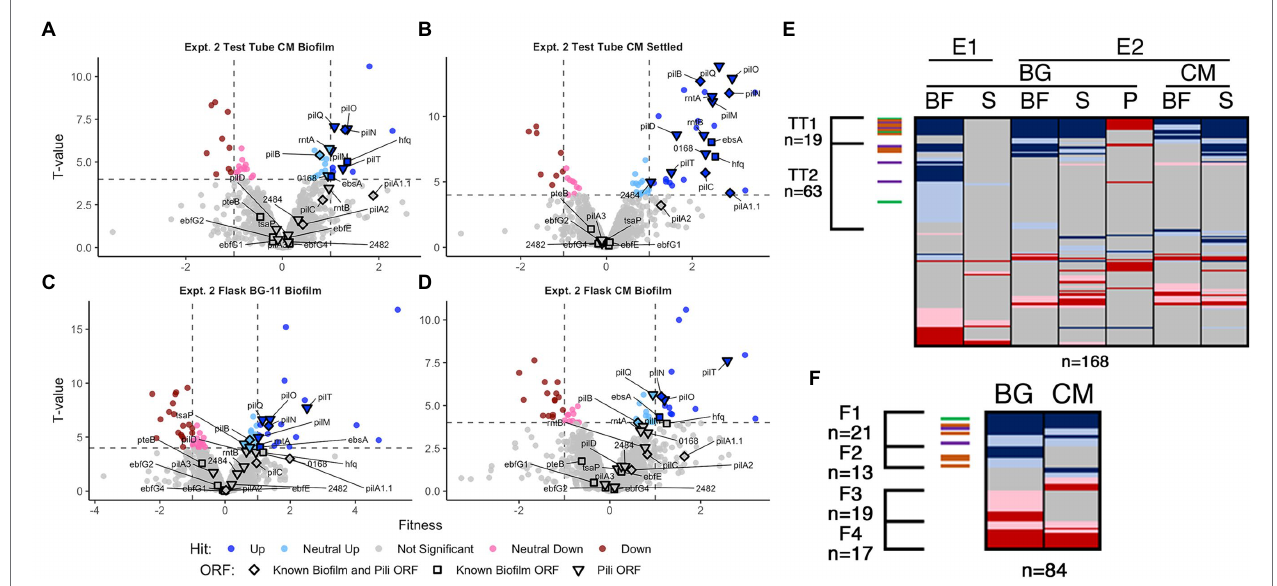
FIGURE 4 | Conditioned media and flask RB-TnSeq analysis Volcano plots of CM test tube (A) biofilm and (B) settled fractions, and biofilm fractions from flask experiments with (C) BG-11 and (D) CM, are presented as described for Figures 1B,C . Comparison of fractions associated with (E) all test tube experiments and (F) flask experiments presented as described for Figure 1D